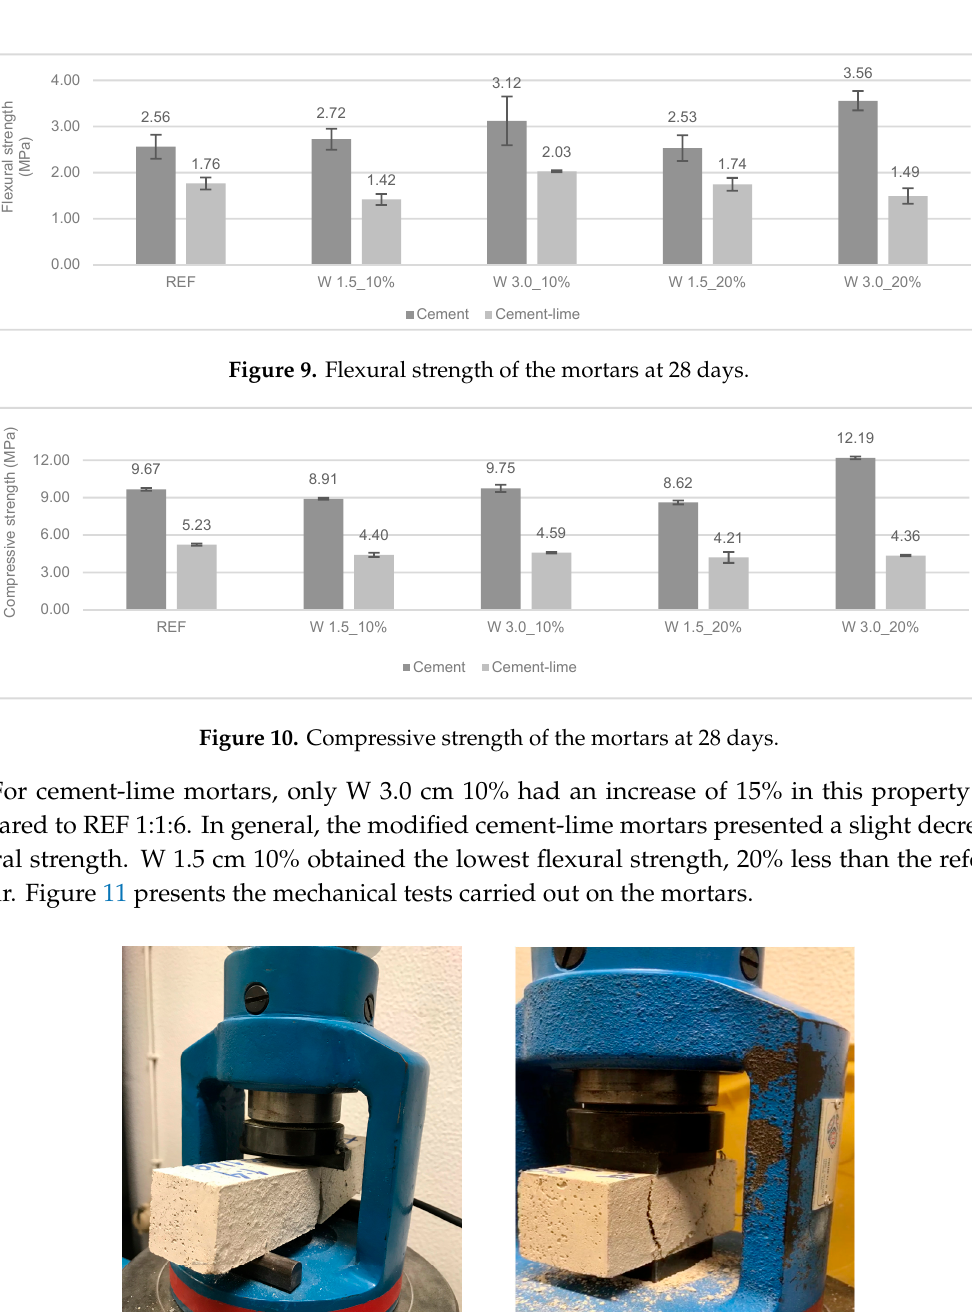
Figure 11. Flexural strength test ( a ); compressive strength test ( b ).